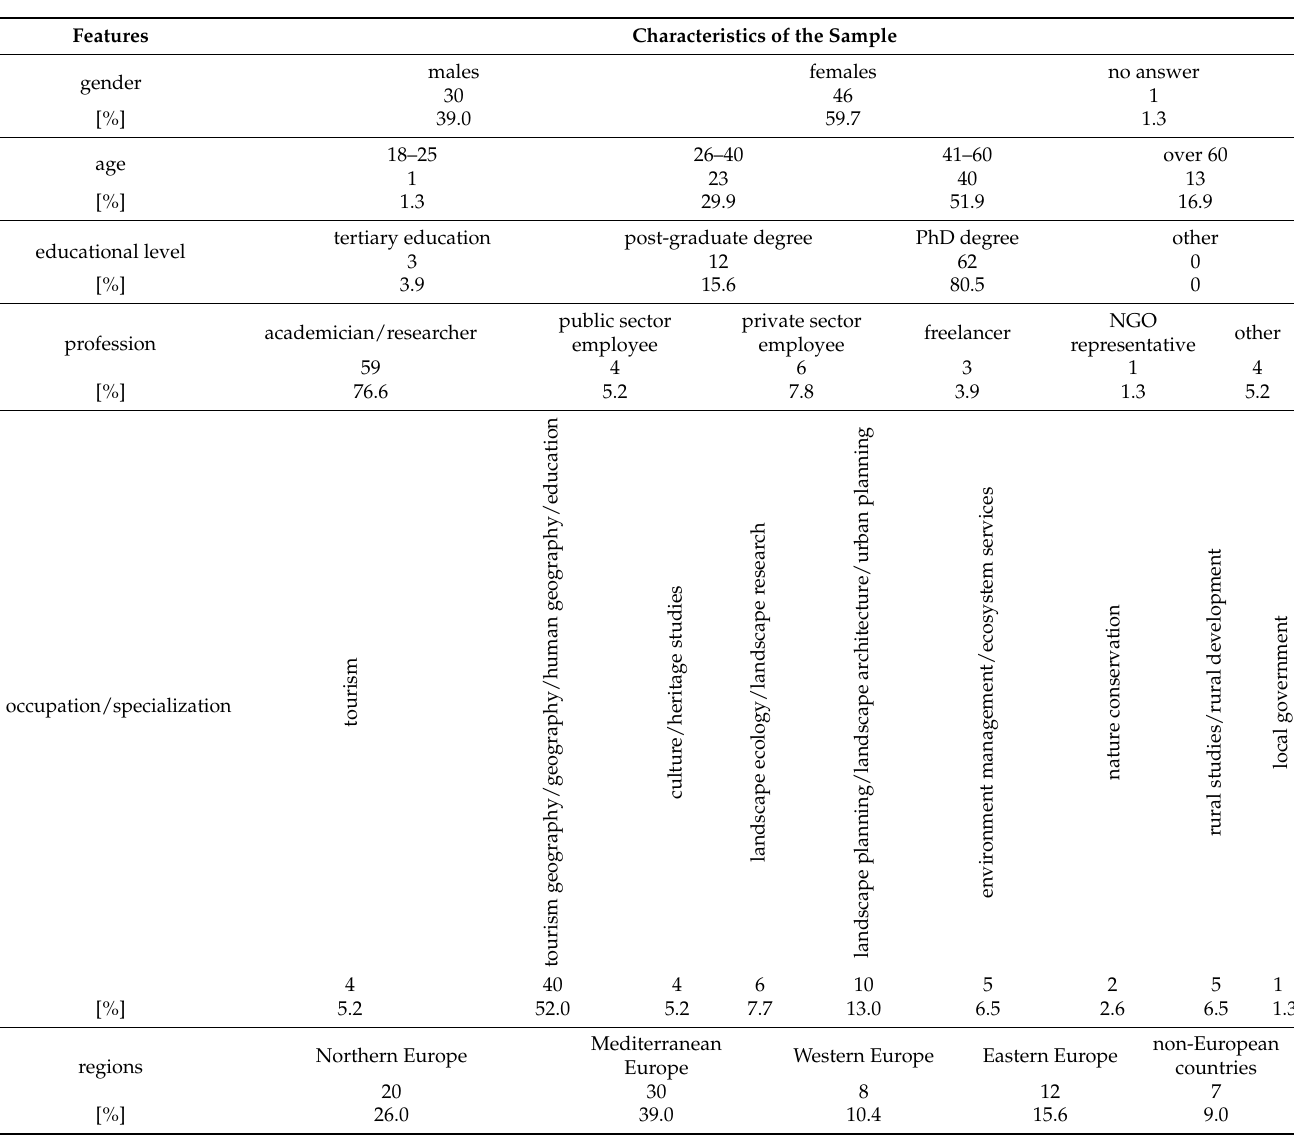
Table 2. Respondent